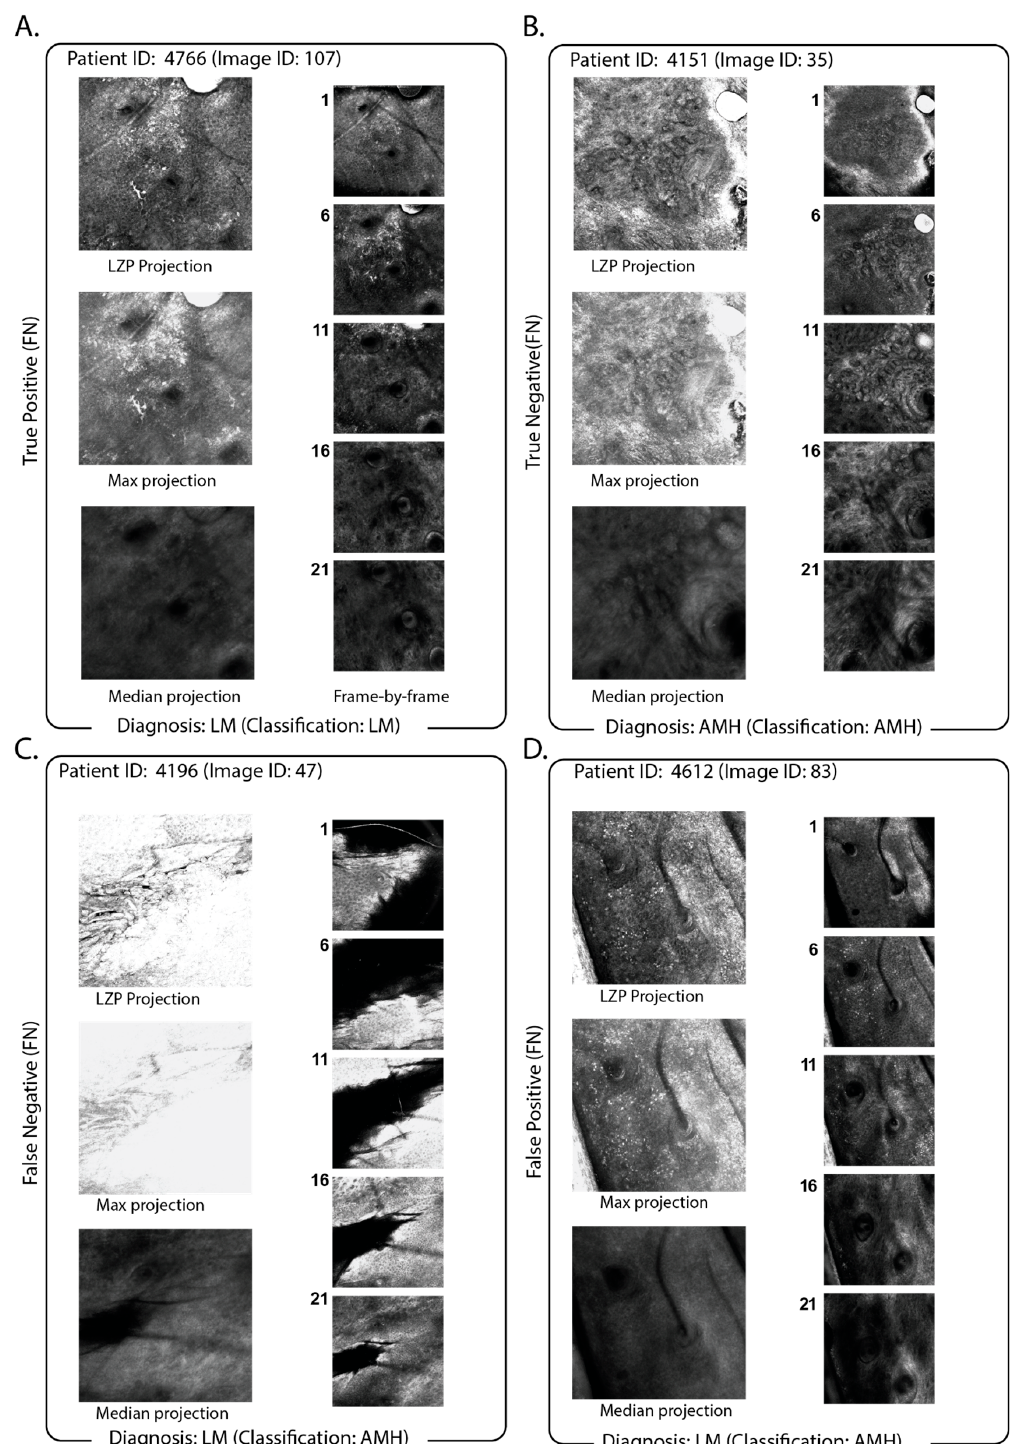
Figure 4. Comparison of LZP projection vs. max- and median-projection for exemplary classification outcomes. Exemplary data for ( A ) LM-diagnosed image stack correctly classified at L; ( B ) AIMP-diagnosed image stack classified as AIMP; ( C ) LM-diagnosed image stack misclassified as AIMP; and ( D ) LM-diagnosed image stack misclassified as LM. For all panels, projections are shown on the left (LZP: top; max-projection: middle; median-projection bottom) with individual slices at specific depths (z = 1, 6, 11, 16, 21) shown inset on the right. Max-projection is generated by taking the maximum value pixel across all slices of the stack, and median-projection is generated by taking the median value pixel across all slices of the stack.